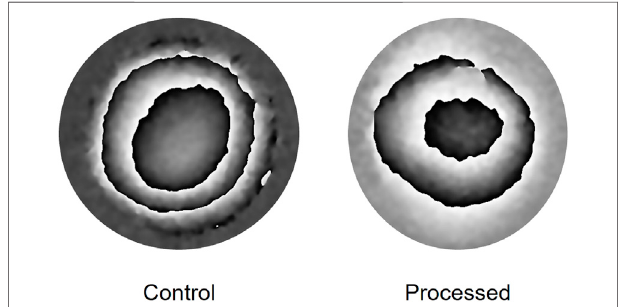
FIGURE 3 | Representative phase wrapped images obtained when imaging the deformation of a lenticule over a pressure increase from 16.50 to 16.94 mmHg.